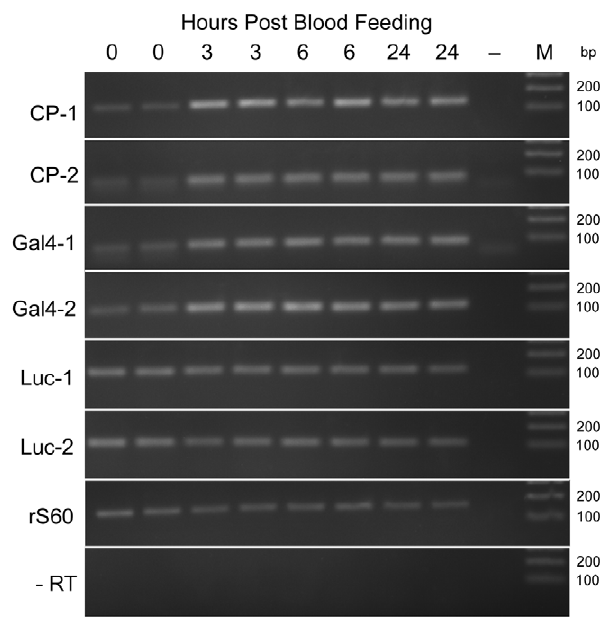
Figure 5. Semi-quantitative RT-PCR of midgut transgene transcription in response to blood feeding. RT-PCR of RNA from female mosquito midguts heterozygous for the Gal4 and UAS transgene cassettes. PCR reactions from two RNA preparations are shown for each timepoint after bloodfeeding. Results from unfed (0 hour), 3, 6 and 24 hour timepoints are shown plus a cDNA free negative control ( 2 ). A DNA ladder is shown with sizes indicated (M). Two independent amplicons were amplified for the native carboxy- peptidase gene (CP), the Gal4 transgene (Gal4) and the luciferase transgene (LUC). Ribosomal S60 (rS60) was used to standardize for RNA quantity and a DNA contamination control was performed using rS60 primers